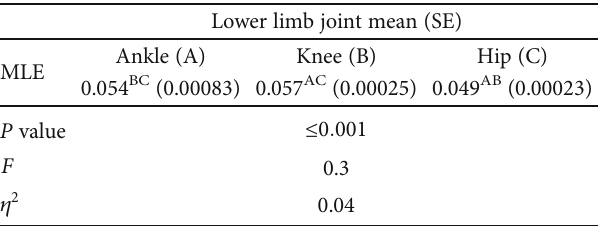
ff erent foot conditions. Figure 3: Average maximum Lyapunov exponent ( λ max ) with SD for (a) joint angles of lower limbs and (b) three di Capital letters denote signi fi cant di ff erence from indicated other lower limb joint (A: ankle; K: knee; H: hip). Table 1: Mean maximum Lyapunov exponent (SE) and post hoc analyses of lower limb joints. A superscript letter denotes signi fi cant di ff erence from the indicated other lower limb